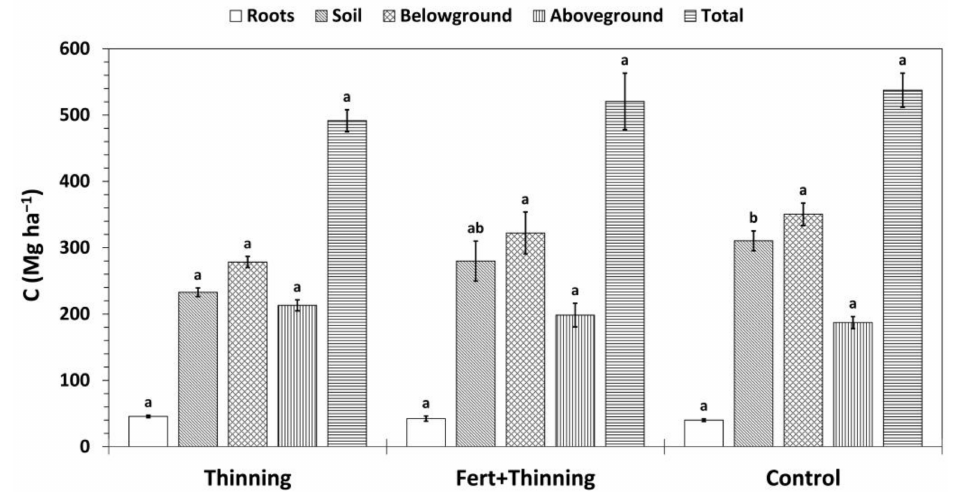
Figure 9. Mean carbon (C) stocks by treatment. Total C stocks are the sum of above- and belowground C stocks, where aboveground and root C stocks include the biomass of thinned trees, and belowground C stocks are the sum of root C and soil organic C (calculated using the mass-based approach). Sample size for all treatment groups and categories is three. Error bars represent ± one standard error. Means within each category accompanied by the same letter (i.e., “a” or “b”) are not significantly different (Tukey’s HSD, α = 0.1). Fert,